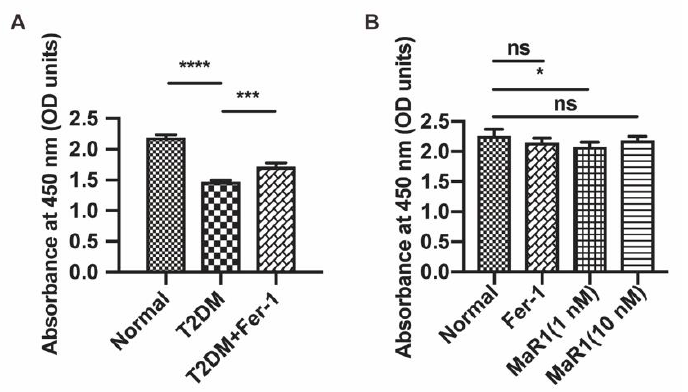
Figure A4. ( A ) Inhibiting ferroptosis promotes poor osteoblast viability under high-glucose condi- tions. ( B ) Ferroptosis inhibitors (Ferrostatin-1, Fer-1) and MaR1 (1 or 10 nM) alone did not cause cell proliferation. Both were shown via the Cell Counting Kit-8 assay. Data are presented as the means ± SDs from three separate experiments (n = 3). ns p > 0.05; * p < 0.05; *** p < 0.001; **** p <